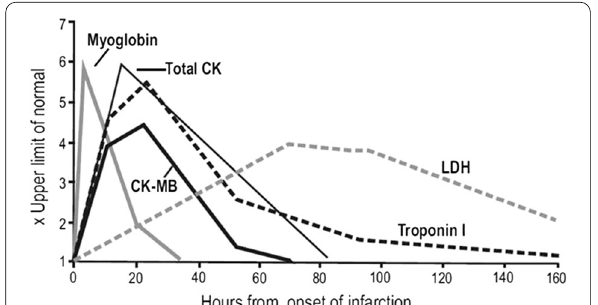
Fig. 1 Routine model of cardiac markers associated with myocardial infarction